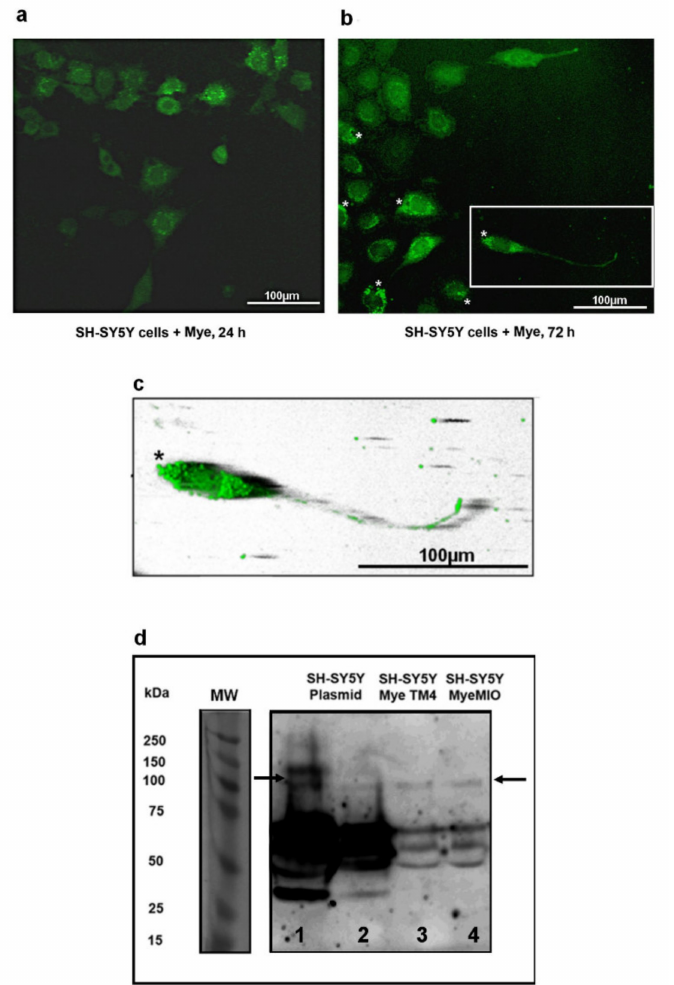
Figure 4. Myelinosomes from MIO-M1 cells carrying mHTT-exon1 protein are incorporated into neu- ronal SH-SY5Y cells. ( a ) Confocal image of live naive SH-SY5Y cells after 24 h exposure to myelinosomes carrying EGFP-mHTT-exon1. ( b ) Confocal image of live naive SH-SY5Y cells after 72 h exposure to myelinosomes carrying EGFP-mHTT-exon1. Asterisks denote the concentration of green staining. Several cells develop the axons (inset); ( c ) is a 3D reconstruction of a selection from ( b ). Asterisk denotes the concentration of green staining. ( d ) WB analysis of EGFP-mHTT-exon1 content in total cell lysates from naive SH-SY5Y cells exposed to myelinosomes emitted by TM4 (line 3) or MIO-M1 (line 4) cells using 1C2 antibody. Lines 1 and 2 show the content of the EGFP-mHTT-exon1 protein in total cell lysates of SH-SY5Y cells transfected with plasmid vector. Note the presence of SDS-soluble oligomers of the EGFP-mHTT-exon1 protein (arrows). Abbreviations: Mye MIO—myelinosomes from MIO-M1 cells; Mye TM4—myelinosomes from TM4 cells; MW—molecular weight. To ensure the incorporation of the EGFP-mHTT-exon1 protein into naive neuronal-like SH-SY5Y cells, we analyzed cell lysates by WB [56] using 1C2 antibody against polyQ- track [57,58]. The lysates of SY-SY5Y cells transfected with plasmid vector carrying EGFP- mHTT-exon1 were used as a control. WB analysis of control preparations (Figure 4d) demonstrated that 1C2 antibody stained 75 kDa protein bands corresponding to the EGFP- mHTT-exon1 protein (strong staining), and two bands migrating as 200 kDa proteins, which seemingly corresponded to the SDS-soluble oligomers of mHTT-exon1 [59]. Both 75 kDa and 200 kDa bands were present on the blots from the lysates of SY-SY5Y cells